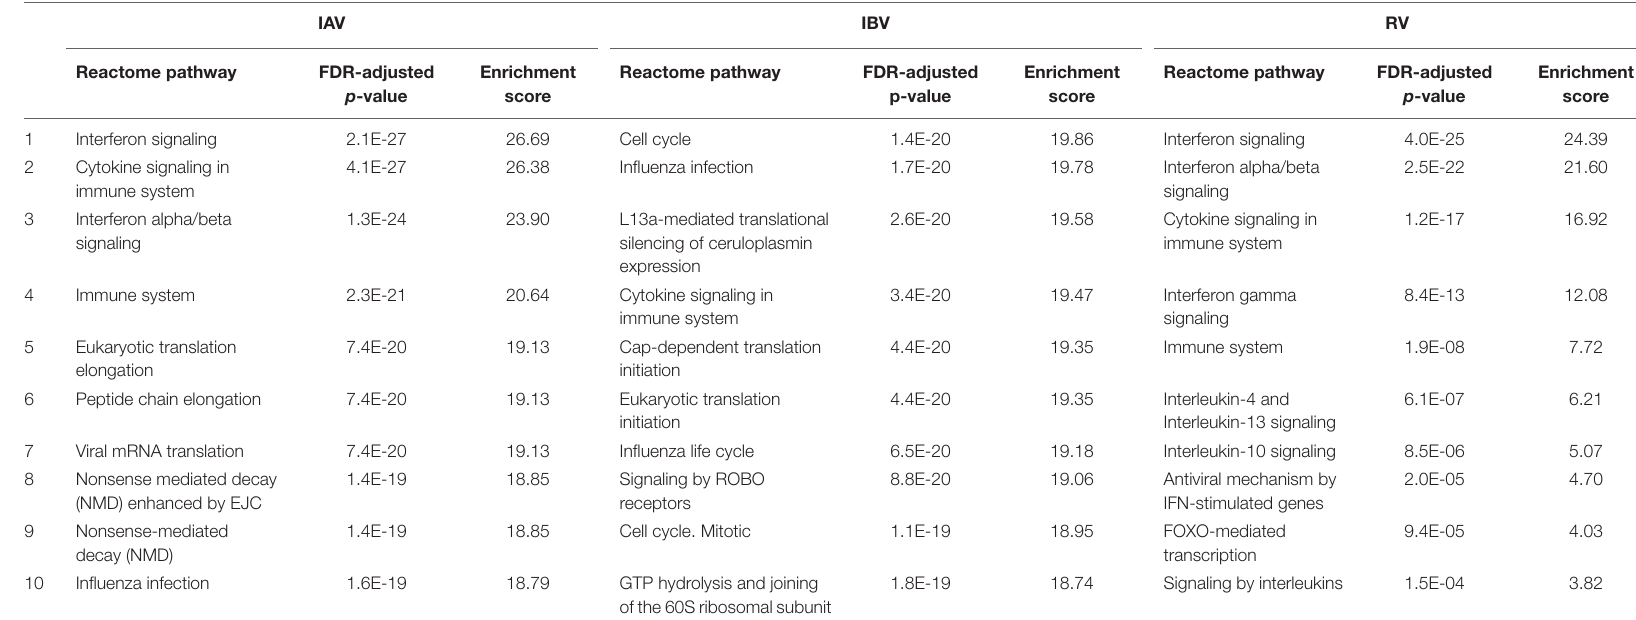
TABLE 2 | Top 10 reactome pathways that enriched for IAV, IBV, or RV infection when compared with mock infection at 12 hpi using g:Profiler analysis. IAV IBV RV Reactome pathway FDR-adjusted p